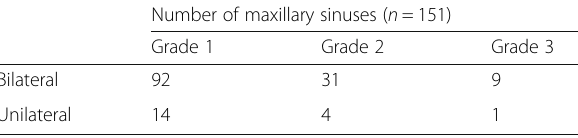
Table 3 Breakdown of maxillary sinus mucosal thickening in 125 patients 1 month after surgery